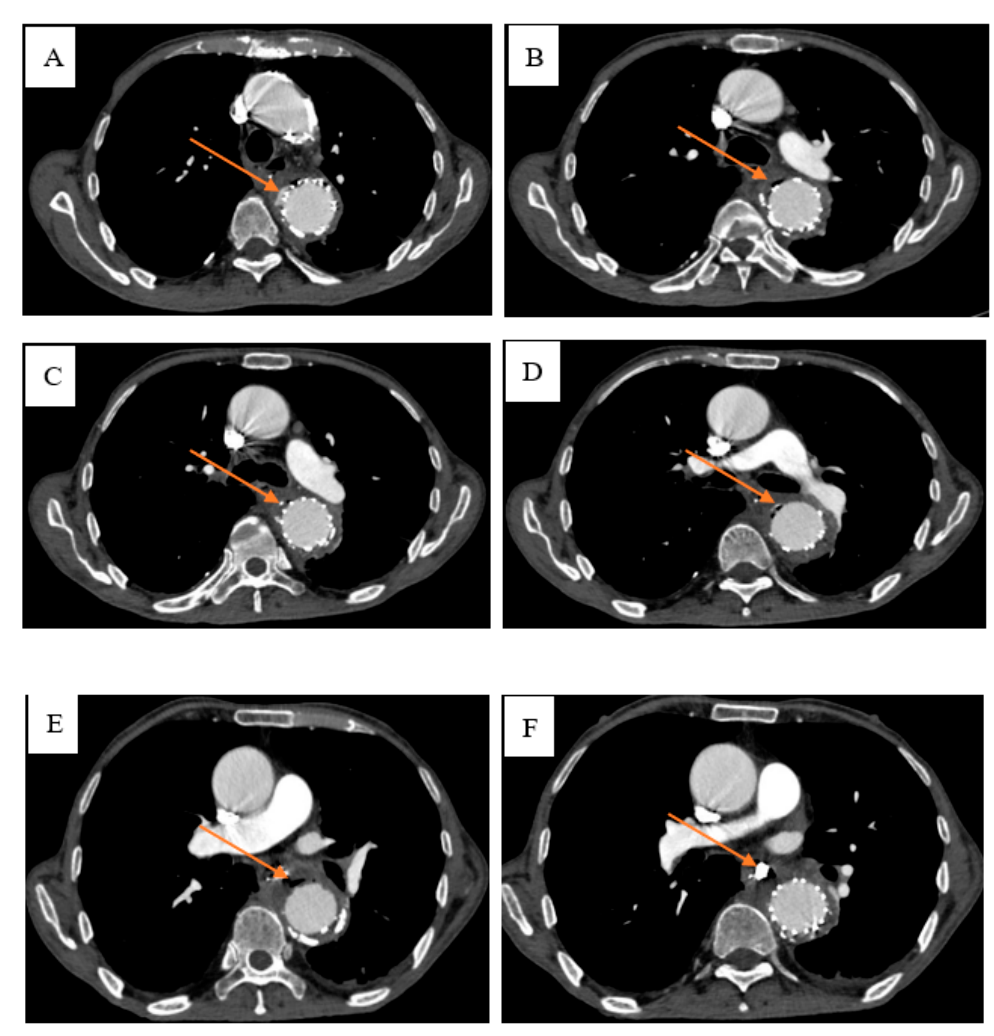
Figure 6. ( A ) Imaging findings of extravasation of blood outside the descending aorta. ( B ) Chest degradation of the aortic vascular wall. ( C ). Check the aortic blood vessel wall calcification stove. ( D ). The gap between the thoracic degradation of the aortic wall blood vessel wall and the membrane bracket. ( E , F ) Imaging findings after treatment of esophageal mediastinal fistula.